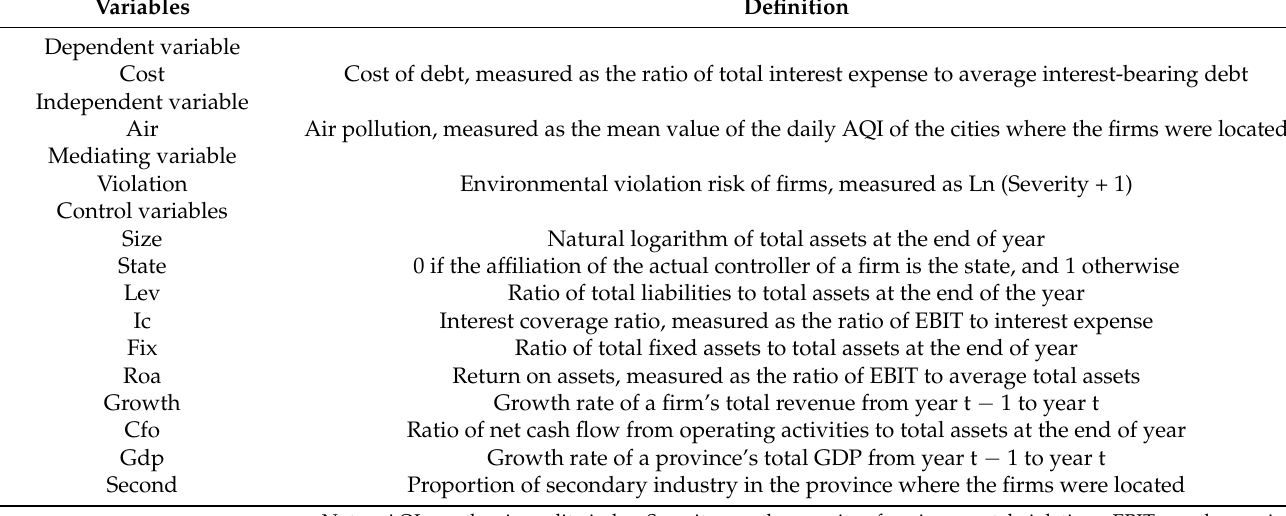
Table 2. Definitions of